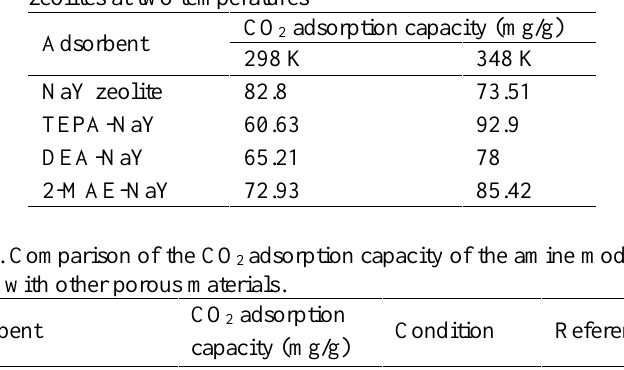
Table 3. CO 2 adsorption capacity of pristine and modified zeolites at two temperatures CO 2 adsorption capacity (mg/g) Adsorbent